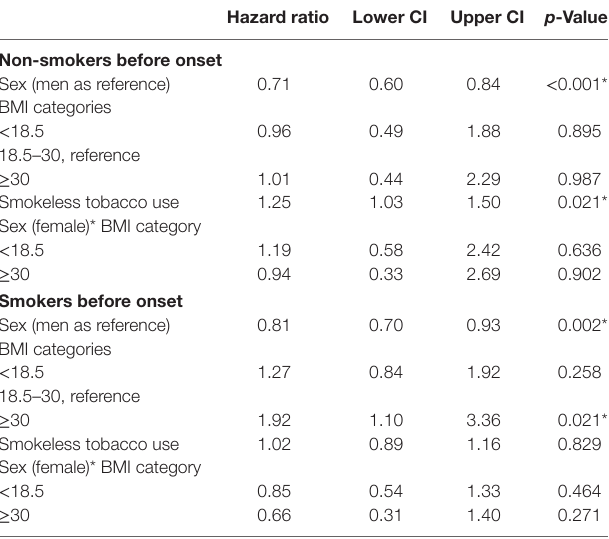
TaBle 4 | Cox regression summary for smokers ( n = 3,282, 1,227 events) and non-smokers ( n = 2,316, 772 events), with interaction present. hazard ratio lower ci Upper ci p -Value